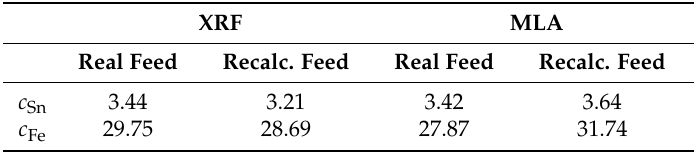
Table 3. X-ray fluorescence (XRF) analysis of c Sn and c Fe measured for real feed and the recalculated feed based on the three products from magnetic separation.